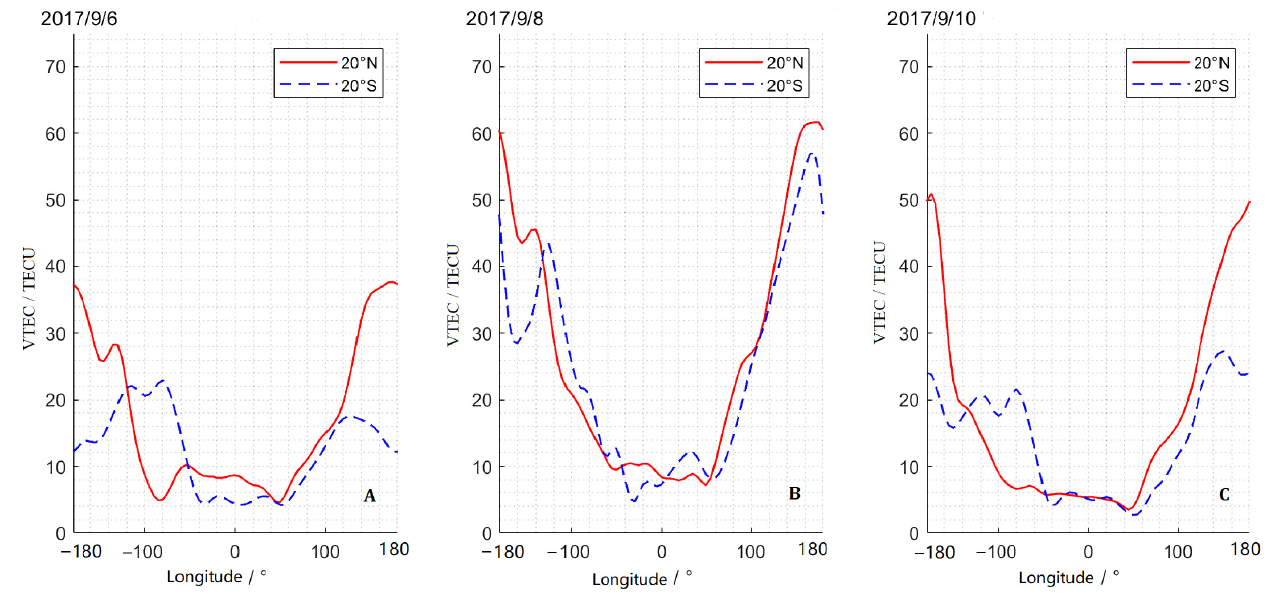
Figure 6. Fluctuation characteristics of VTEC on 20° N/S latitudes at UTC 2:00. The blue dotted line and the red solid line represent the southern and northern hemisphere VTEC, respectively, unit: TECU. Panels ( A – C ) show the VTEC characteristics of the pre-, mid- and post-geomagnetic storm phases, respectively.